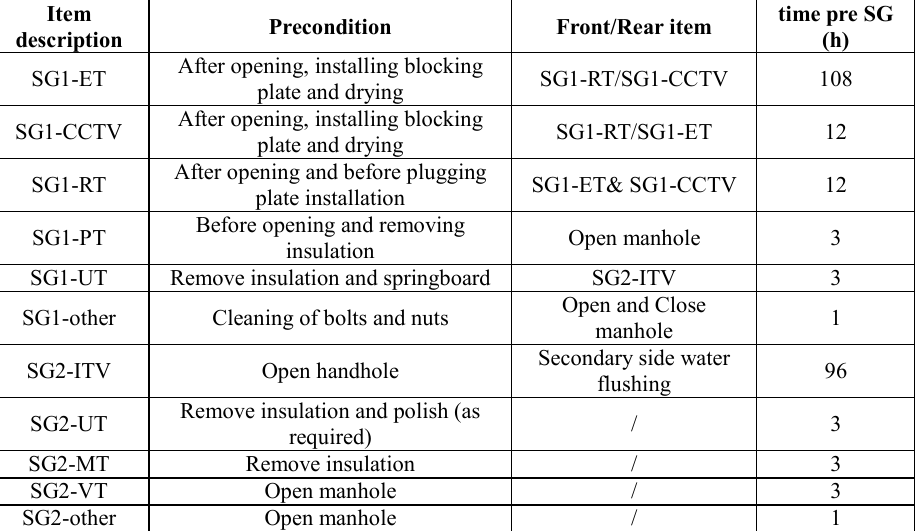
Table 1. The implementation information of each SG ISI